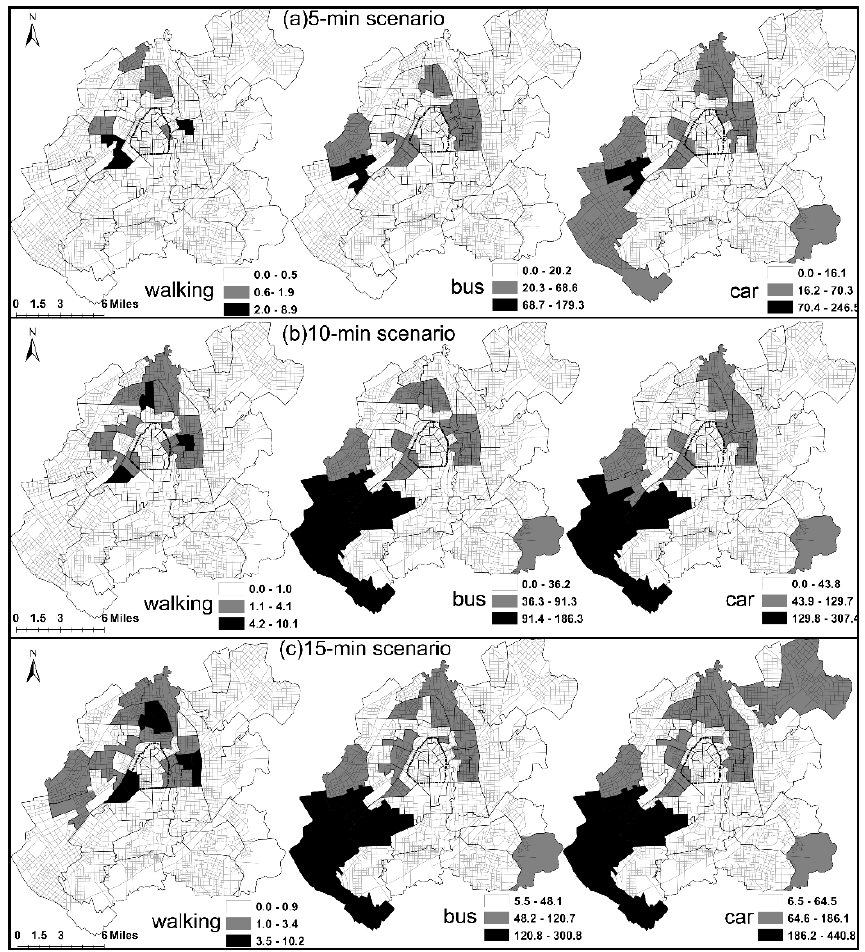
Figure 4. The geography of SE i under different trip modes . ( a ) 5-min scenario; ( b ) 10-min scenario; ( c ) 15-min scenario.